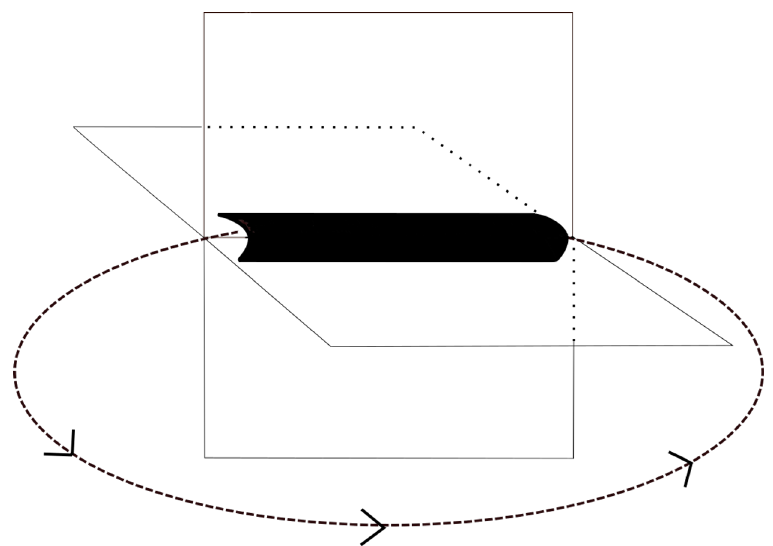
Figure 2 . Short open string connecting two localized objects. The ellipse with attached arrows represents that the string is wrapped around the intersection